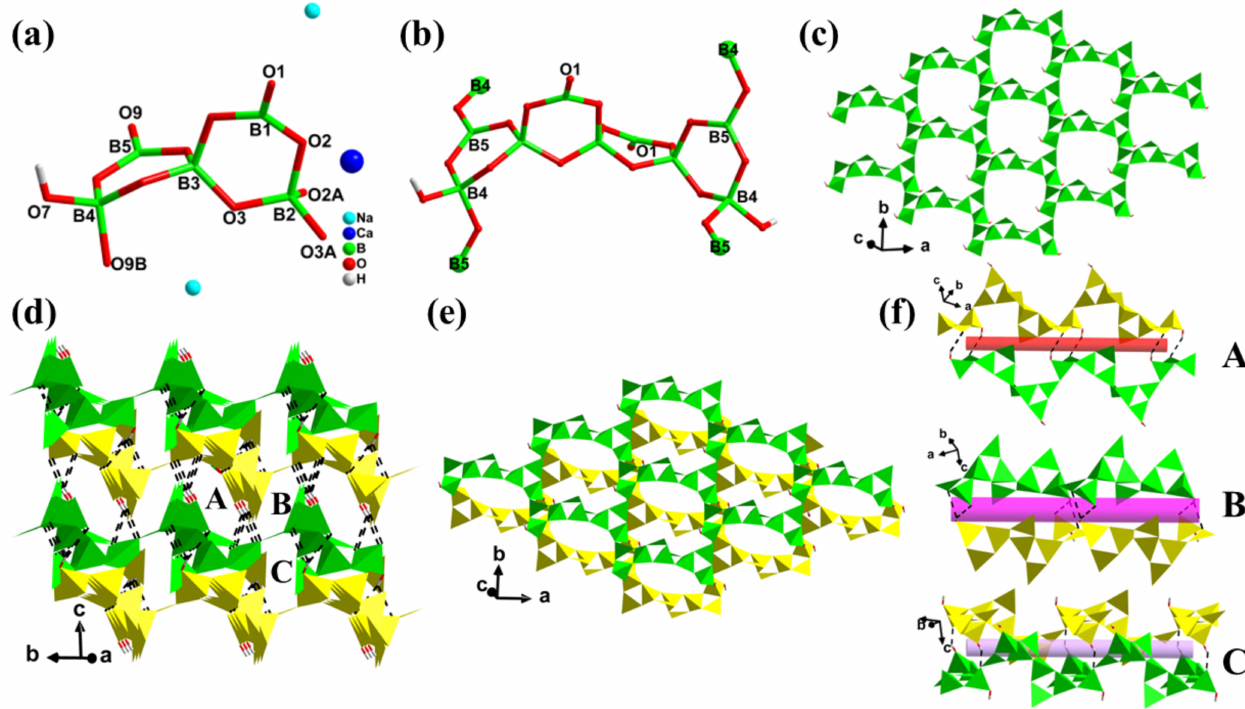
Figure 2. ( a ) Asymmetric unit of 2 . ( b ) Four-coordinated [B 9 O 18 (OH) 2 ] 11 − FBB in 2 . ( c ) The 2D layer with 14-MR windows. ( d ) The 3D supramolecular framework of 2 . ( e ) View of the adjacent layers with dislocation along c axis. ( f ) Three types of supramolecular channels in 2 . Symmetric codes: A: 1 − x, y, 0.5 − z; B: 0.5 − x, − 0.5 + y, 0.5 −